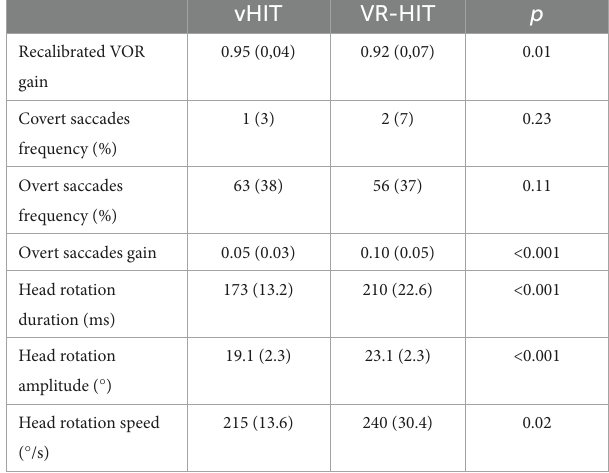
TABLE 1 Comparison of eye/head movement parameters between vHIT and VR-HIT under normal visual feedback.